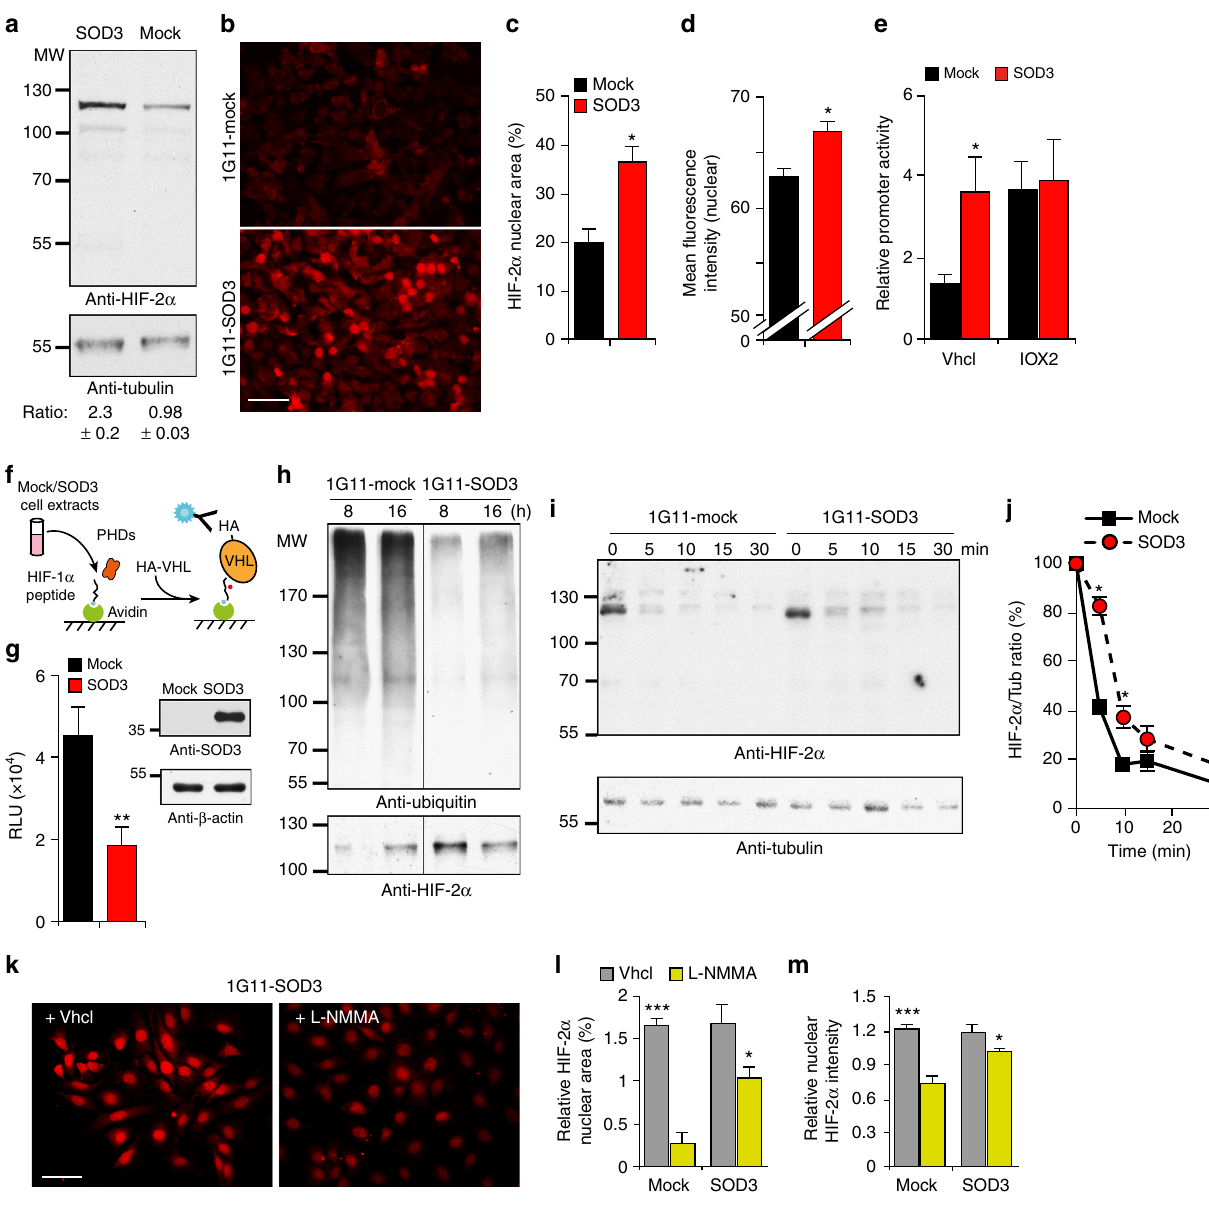
Fig. 6 SOD3 stabilizes HIF-2 α posttranscriptionally via NO. a Immunoblot analysis of 1G11-mock and -SOD3 cell extracts with anti-HIF-2 α and -tubulin antibodies ( n = 2). The ratio between bands is shown (bottom). b Immuno fl uorescence analysis of HIF-2 α staining in mock and SOD3-expressing cells ( n ≥ 500 cells/condition). c , d Percentage of nuclear area and mean fl uorescence intensity in images in b . e Relative VEC promoter activity in IOX2- or Vhcl-treated 1G11-mock and -SOD3 cells. f Scheme of the ELISA used to detect PHD activity. g PHD activity, determined by ELISA, in mock and SOD3- expressing cell extracts. SOD3 levels are shown in these cells as determined by immunoblot (actin loading control; n = 3). h Top, HIF-2 α ubiquitination analysis in immunoprecipitates of MG132-treated 1G11-mock and -SOD3 cells at the indicated times. Bottom, rehybridization with anti-HIF-2 α antibody. i Immunoblot of HIF-2 α in extracts from 1G11-mock and -SOD3 cells cultured in hypoxia (6 h), cycloheximide treated, and cultured in normoxia for the indicated times. Blots were rehybridized for tubulin as loading control. A representative experiment is shown ( n = 4). j Quanti fi cation of the HIF-2 α /tubulin densitometry ratio from i , expressed as the percentage of the ratio at time 0 (hypoxic conditions, 100%). k Representative images of Vhcl- or L-NMMA- treated 1G11-SOD3 cells stained with anti-HIF-2 α antibodies. l , m Relative percentage of stained nuclear area and mean fl uorescence intensity in Vhcl- or L- NMMA-treated 1G11-mock and -SOD3 cells. Values were normalized to the lowest value in the Vhcl-treated group for each cell type ( n ≥ 100 cells/ condition). For a , c – e , g , j , l , m , data shown as mean ± SEM from at least three independent experiments. * p < 0.05, ** p < 0.01, *** p < 0.001; two-tailed Student ’ s t -test ( c , e , g , l , m ) or two-way ANOVA with Bonferroni post-hoc test ( j ), showing signi fi cant differences between cell lines. Bar, 30 μ